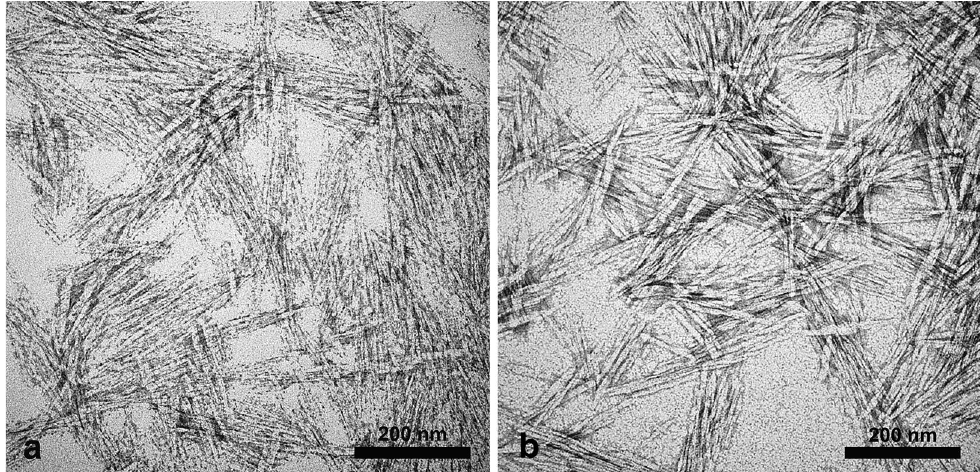
Figure 1. Ultrastructural characterization by TEM of CNCs bleached at 3% ( a ) and 5% ( b ).